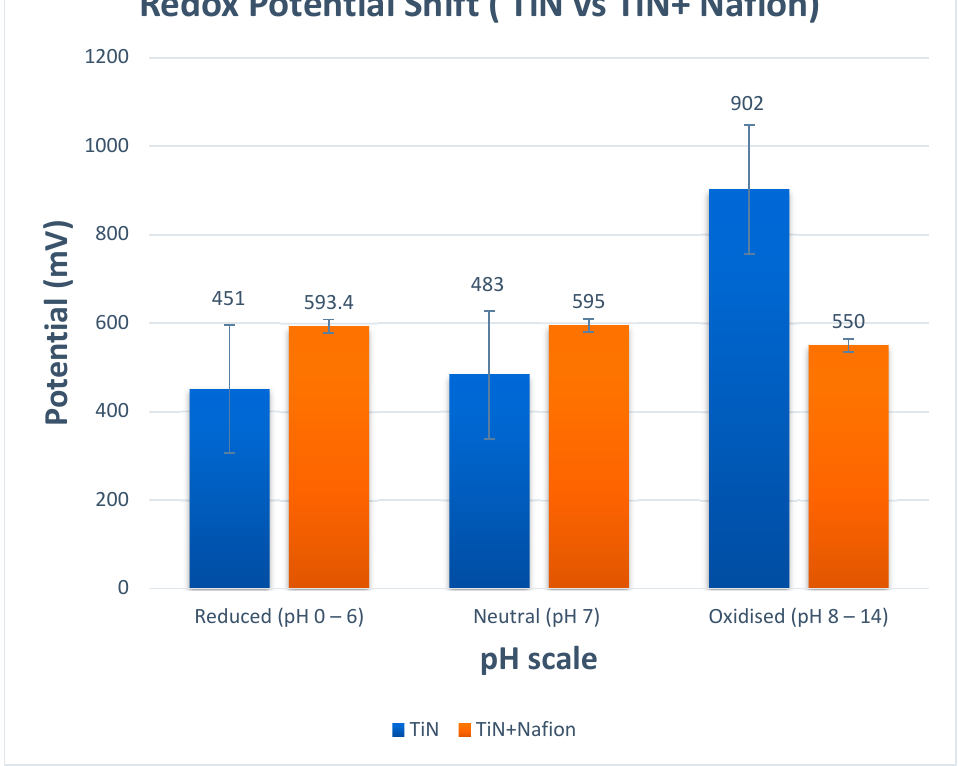
Figure 3. Potential versus different matrices for TiN and TiN + Nafion working electrode.